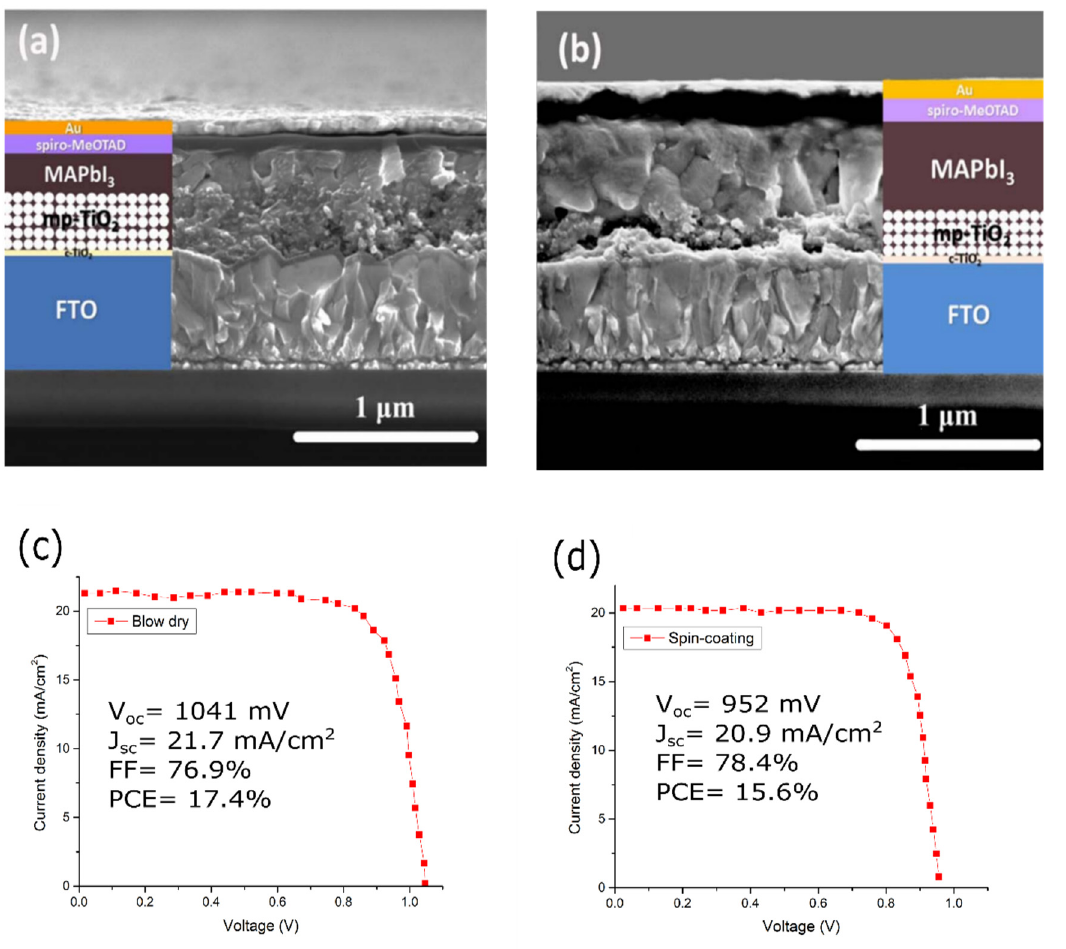
Figure 5. SEM images and J-V curve of the fabricated devices by using: ( a , c ) blow-dry and ( b , d ) spin-coating methods [117]. Reproduced with permission from Ref. [117]. Copyright 2017 Solar Energy Materials and Solar Cells.